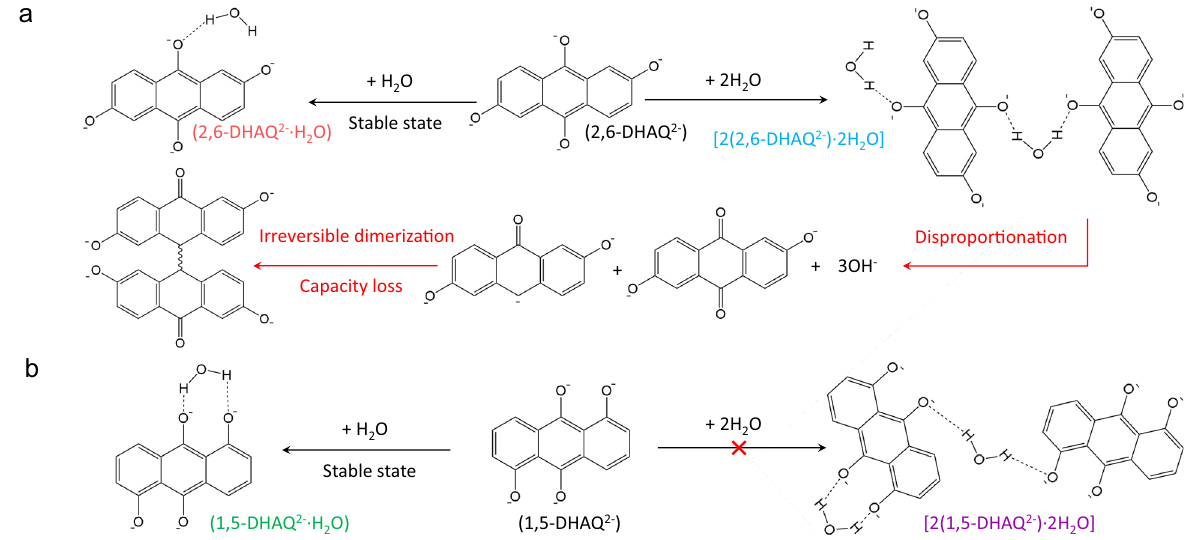
Fig. 2 | Proposed mechanism of hydrogen bonding involved degradation and protection of DHAQ 2 − . a The hydrogen bond-mediated degradation process of 2,6-